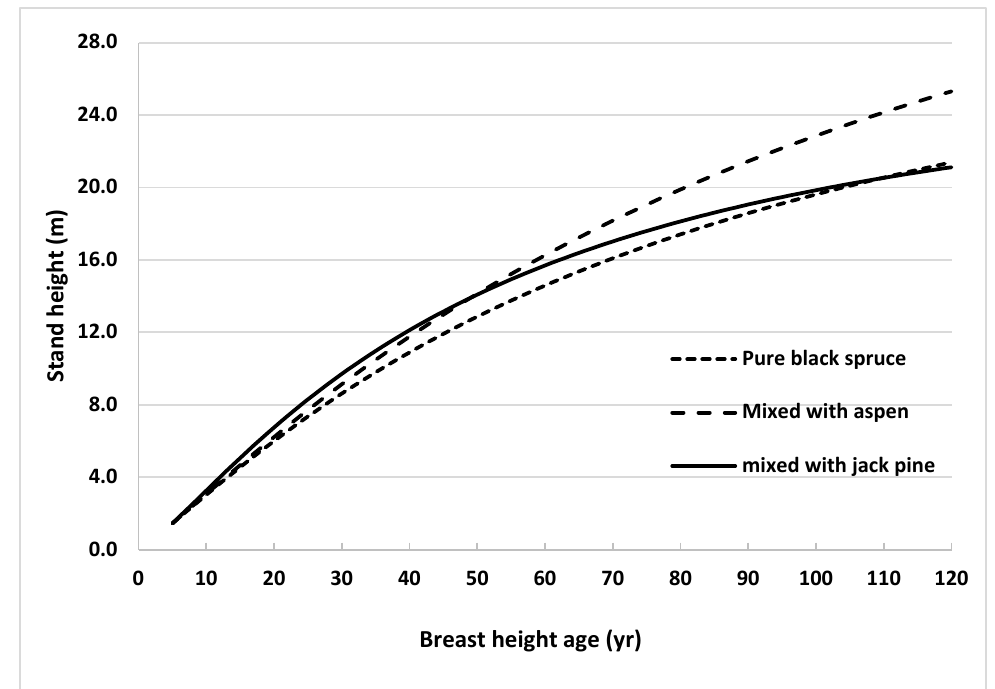
Figure 4. Height growth curves generated using Equation (3) for black spruce grown in natural origin mixed stands of northern Ontario, Canada, using average observed heights at breast height age 5 years (1.46 m) as starting values, with trembling aspen and jack pine (using the same equation with the parameters described in Table 3 of Sharma (2021)) compared with height growth curves for natural pure stands generated using the same equation with the parameters described in Table 3 of Sharma and Reid (2018).